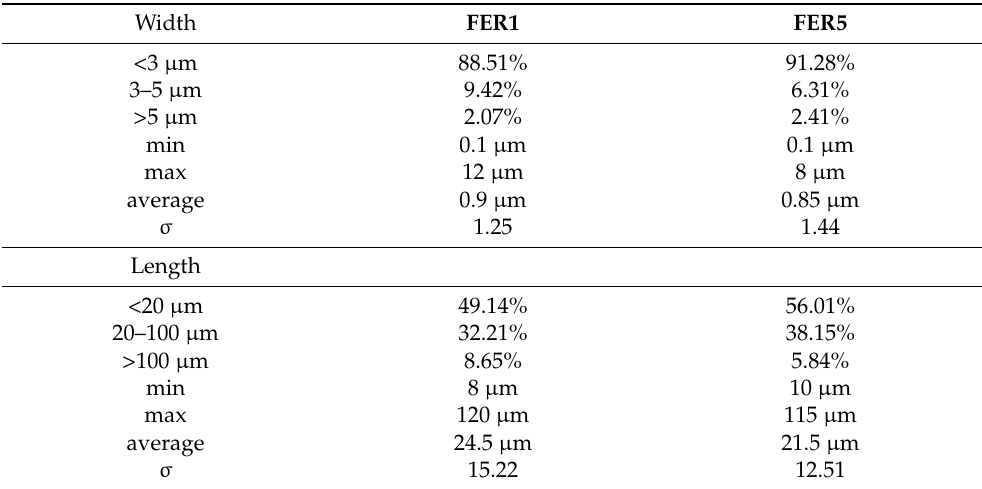
Table 1. Results of SEM dimensional analysis of ferrierite